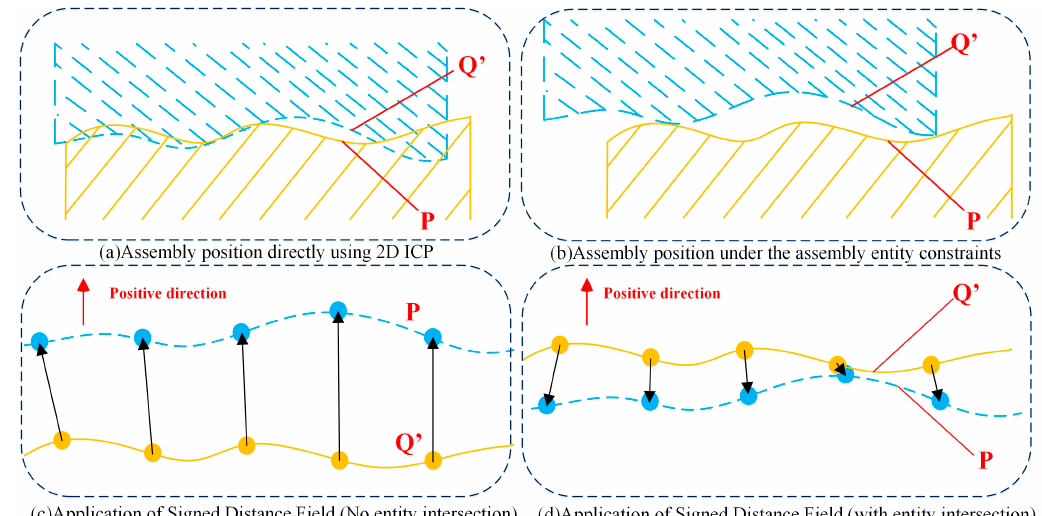
Figure 2. Illustration of assembly entity constraints and the application of a signed distance field in realizing the rule.